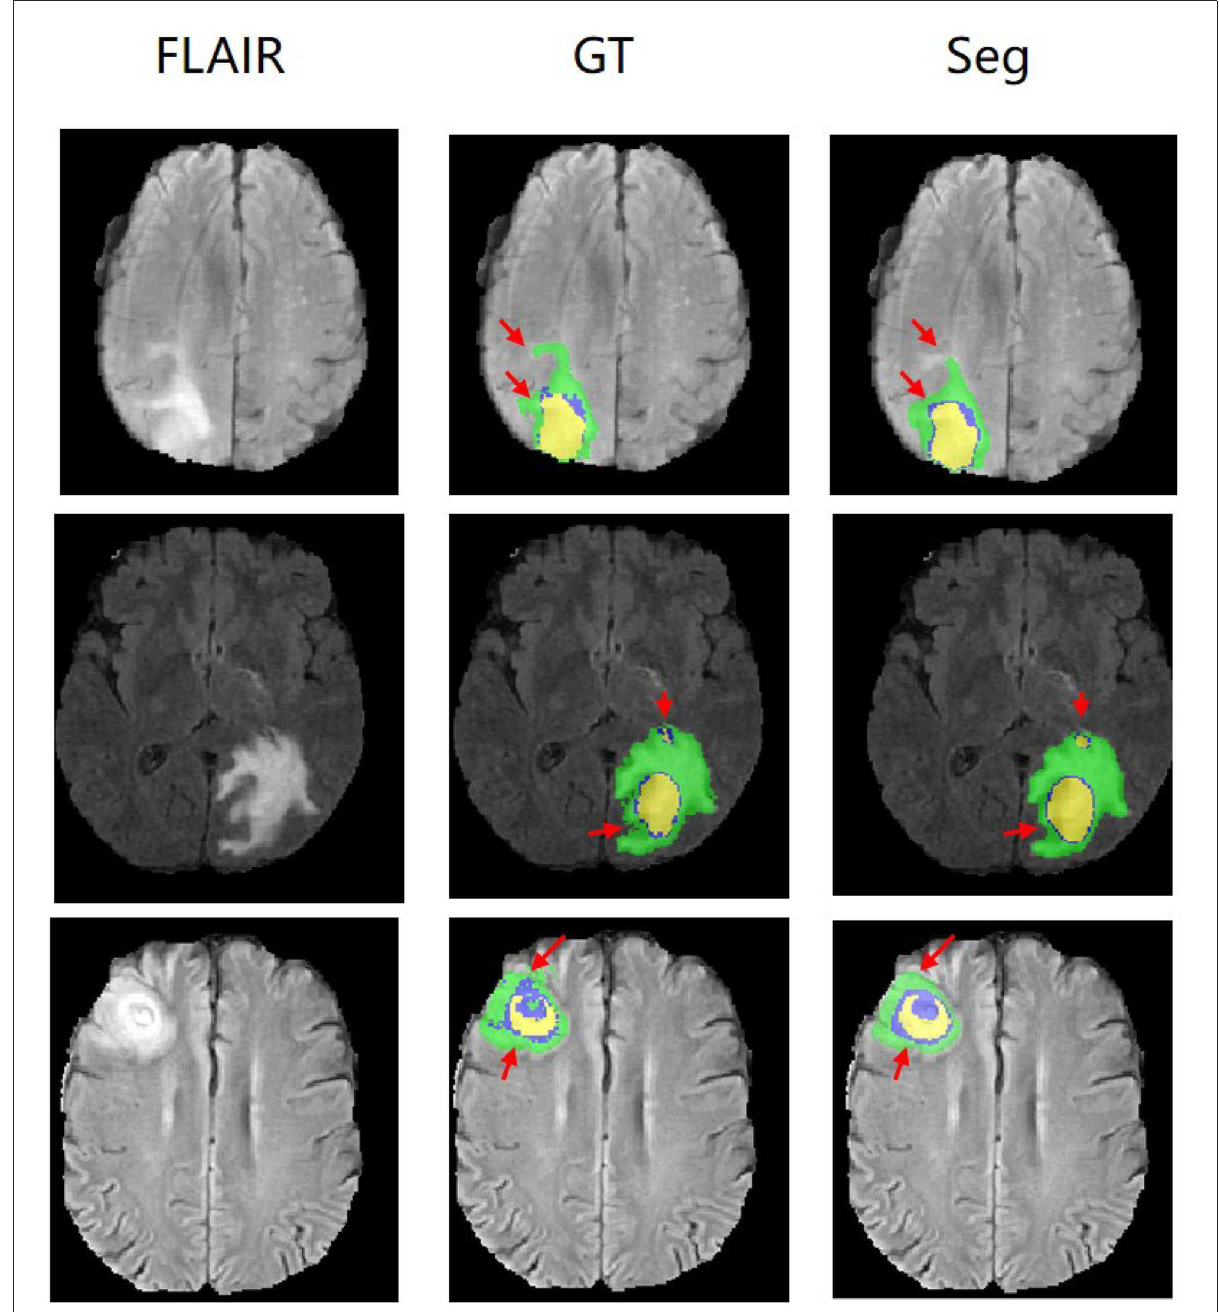
FIGURE5 Experimental results with corresponding slices on BRATS2015 validation set. The red arrows locate the mainly different regions between GT and segmentation